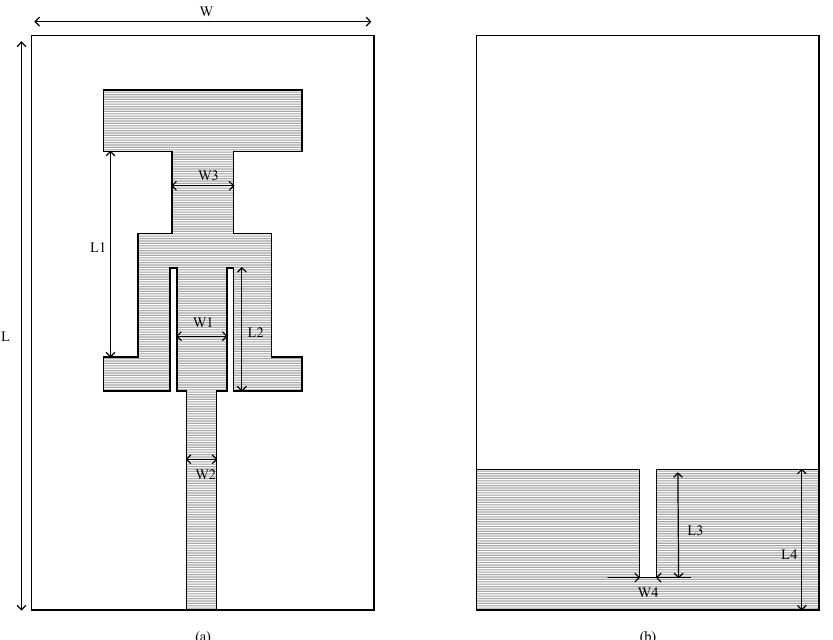
Figure 8. Structure diagram of planar tri-band antenna: ( a ) front structure of the antenna; ( b ) reverse structure of the antenna.